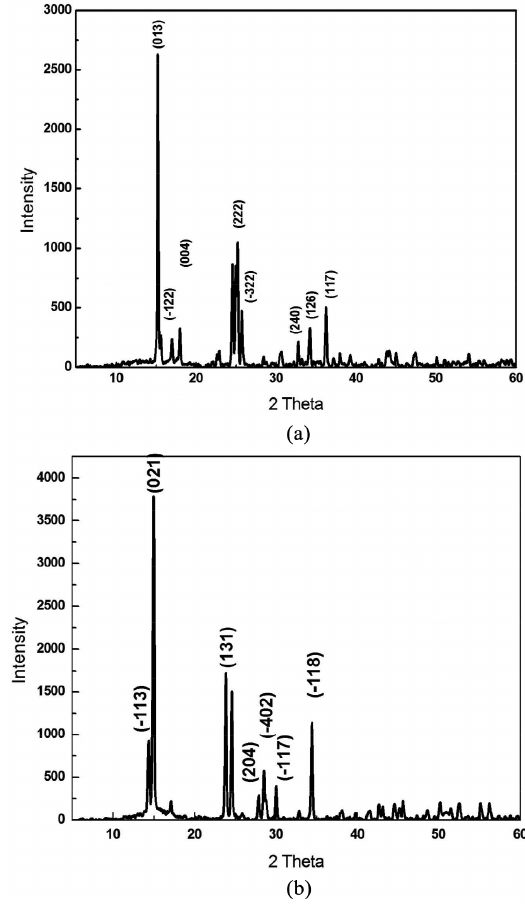
Figure 4. XRD of (a) dopant metal complex (b) PANI composite.